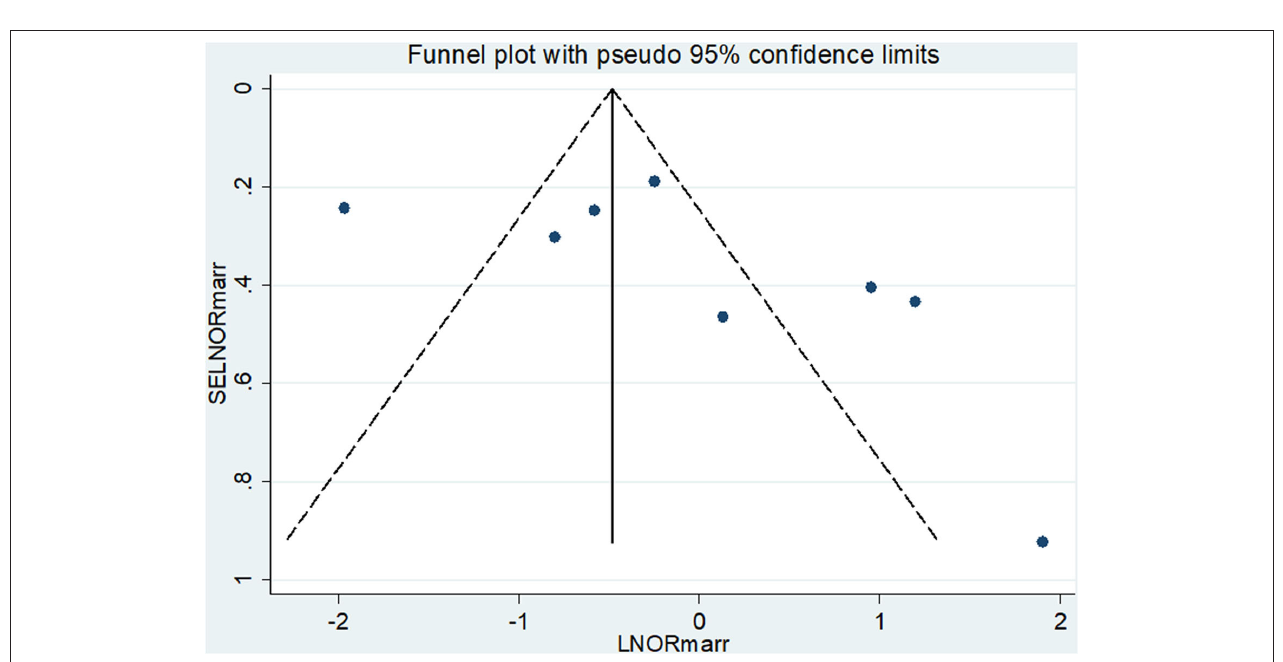
FIGURE 10 | Funnel plot for publication bias, LNORmarr represented in the x -axis and standard error of SELNORmarr on the y -axis.